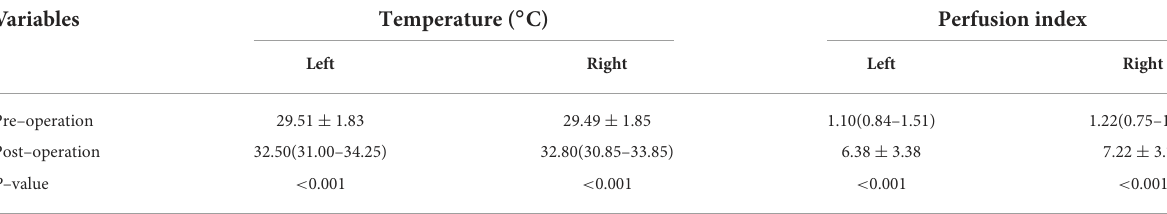
TABLE 3 Comparison temperature and perfusion index before and after modulation (mean ± sd or IQR).